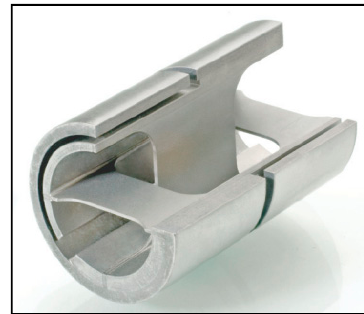
Figure 1. Brazed or welded stainless steel cantilevered pivot bearing of the Riverhawk Company.